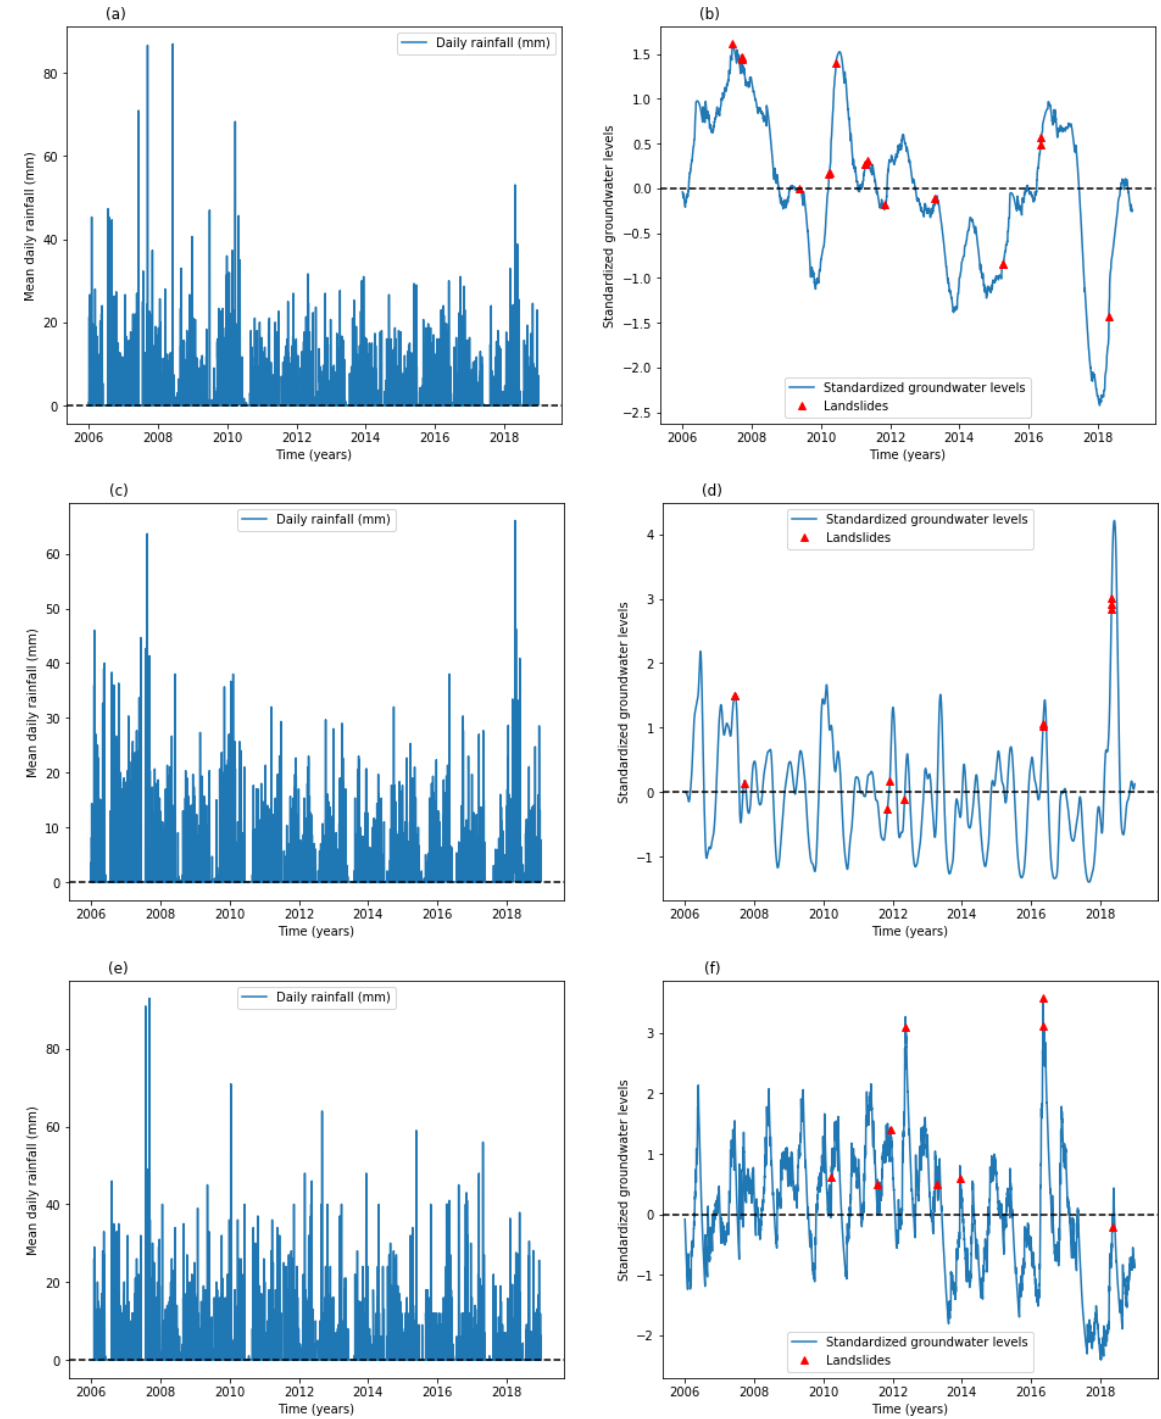
Figure 5. (a) Mean daily catchment rainfall and (b) catchment mean standardized groundwater simulated with TFN model using meteo- rological data from Kivu catchment as model inputs, (c) mean daily catchment rainfall and (d) catchment mean standardized groundwater simulated with TFN model using meteorological data from upper Nyabarongo catchment as model inputs, and (e) mean daily catchment rainfall and (f) catchment mean standardized groundwater simulated with TFN model using meteorological data from Mukungwa catchment as model inputs; landslides represented with red